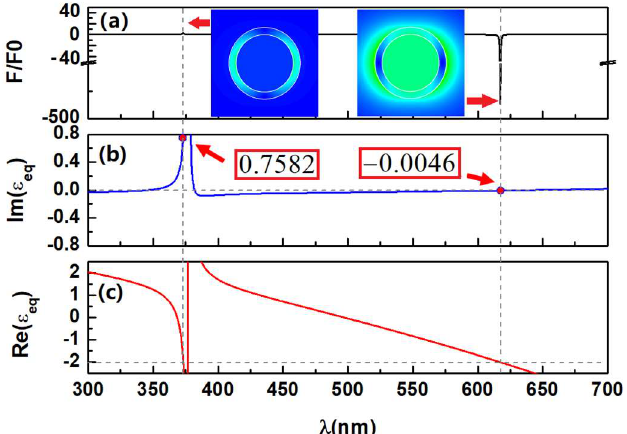
Figure 4. ( a ) Normalized optical force for the case of the high aspect ratio, as shown in Figure 2, with ε cg = − 0.07 and h = 0.3. ( b ) The imaginary and ( c ) real parts of the equivalent permittivity. The insets in ( a ) indicate the near field intensity distributions at the resonant wavelengths.